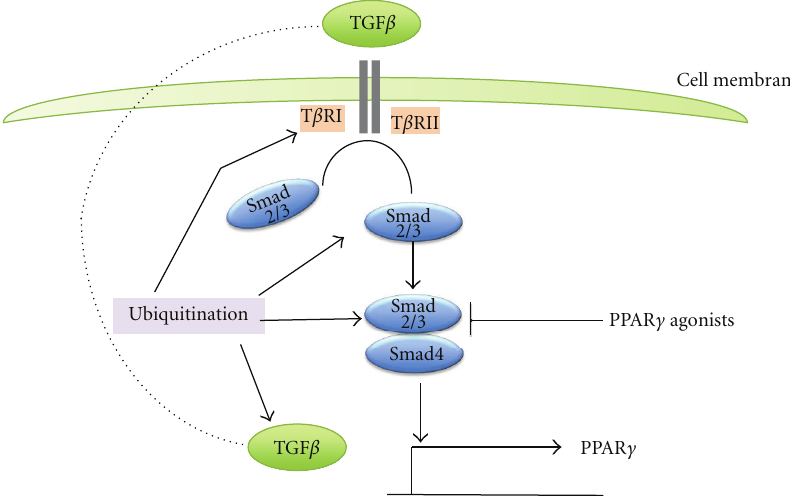
Figure 4: The TGF β pathway and regulations by ubiquitination and PPAR γ . Its deregulation by Smad4 mutations may lead to PPAR γ upregulation in pancreatic carcinomas. Several components of TGF β pathway are targets of ubiquitination with degradative and nondegradative